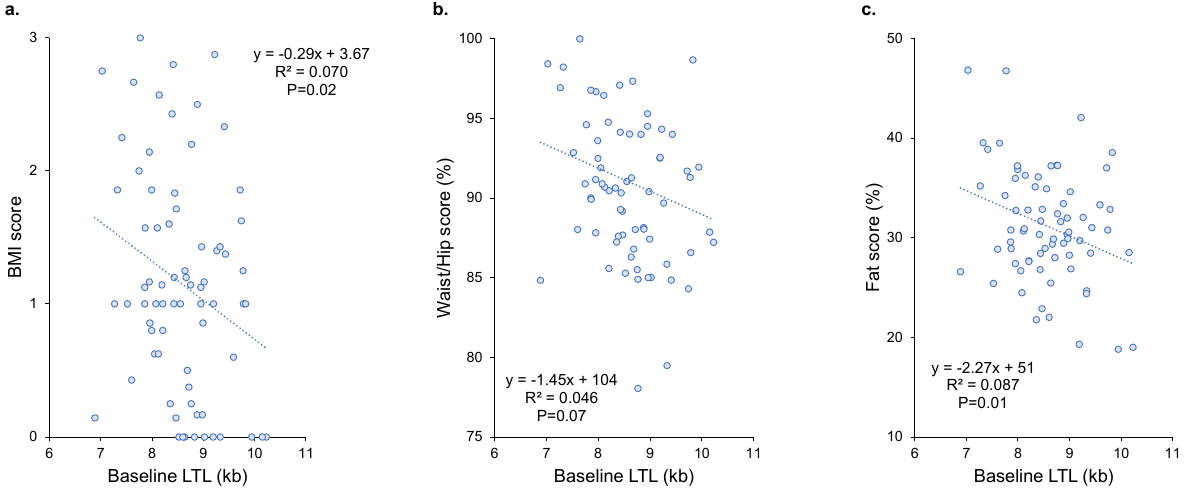
Figure 3. Relationships between baseline LTL and BMI ( a ), waist/hip ( b ), and fat percentage ( c ) scores. R 2 and p are from Pearson’s correlation. LTL = leukocyte telomere length; kb = kilobase; BMI = body mass index. Table 2. Multivariate models analyzing the effects of LTL and covariates on obesity scores.